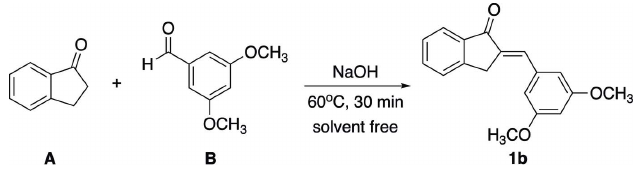
Figure 1 Green synthesis scheme for indanone-based